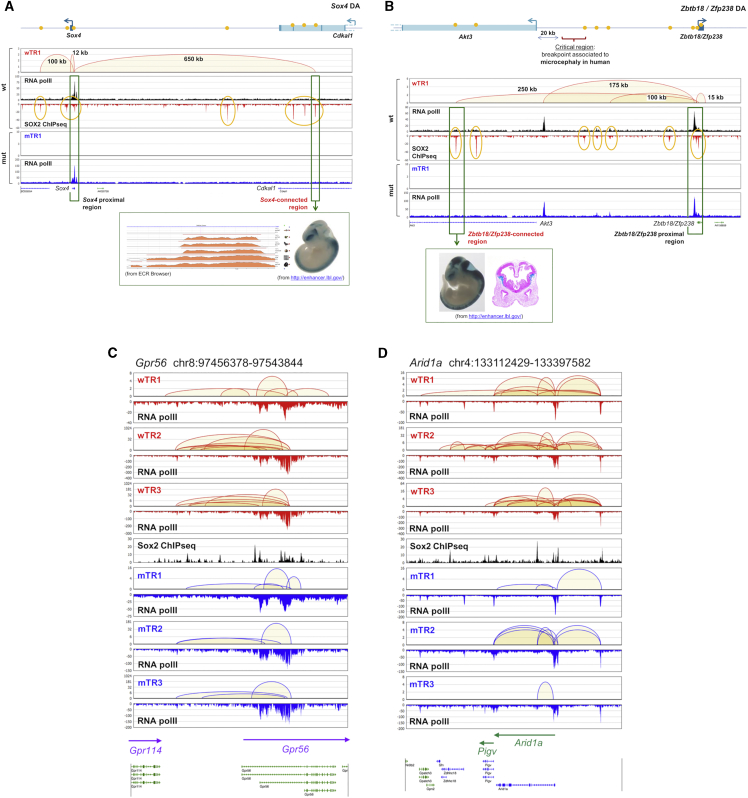
Distal Anchors Connected by Sox2-Dependent Interactions to Genes Important in Neural Development and Disease(A and B) Sox2-dependent ChIA-PET interactions (TR1) between two different genes (Sox4, A; Zbtb18, B) and distal regions overlapping previously characterized “VISTA” enhancers (Visel et al., 2009); SOX2 ChIP-seq peaks (present paper), lacZ-stained transgenic embryos (from https://enhancer.lbl.gov), and evolutionary conservation (ECR browser).(C and D) Sox2-dependent interactions (wTR1, wTR2, wTR3, mTR1, mTR2, and mTR3) involving Gpr56 (C) and Arid1a (D), two genes whose human homologs are involved in neurodevelopmental brain disease.See also Figure S5 and Tables S5 and S6.